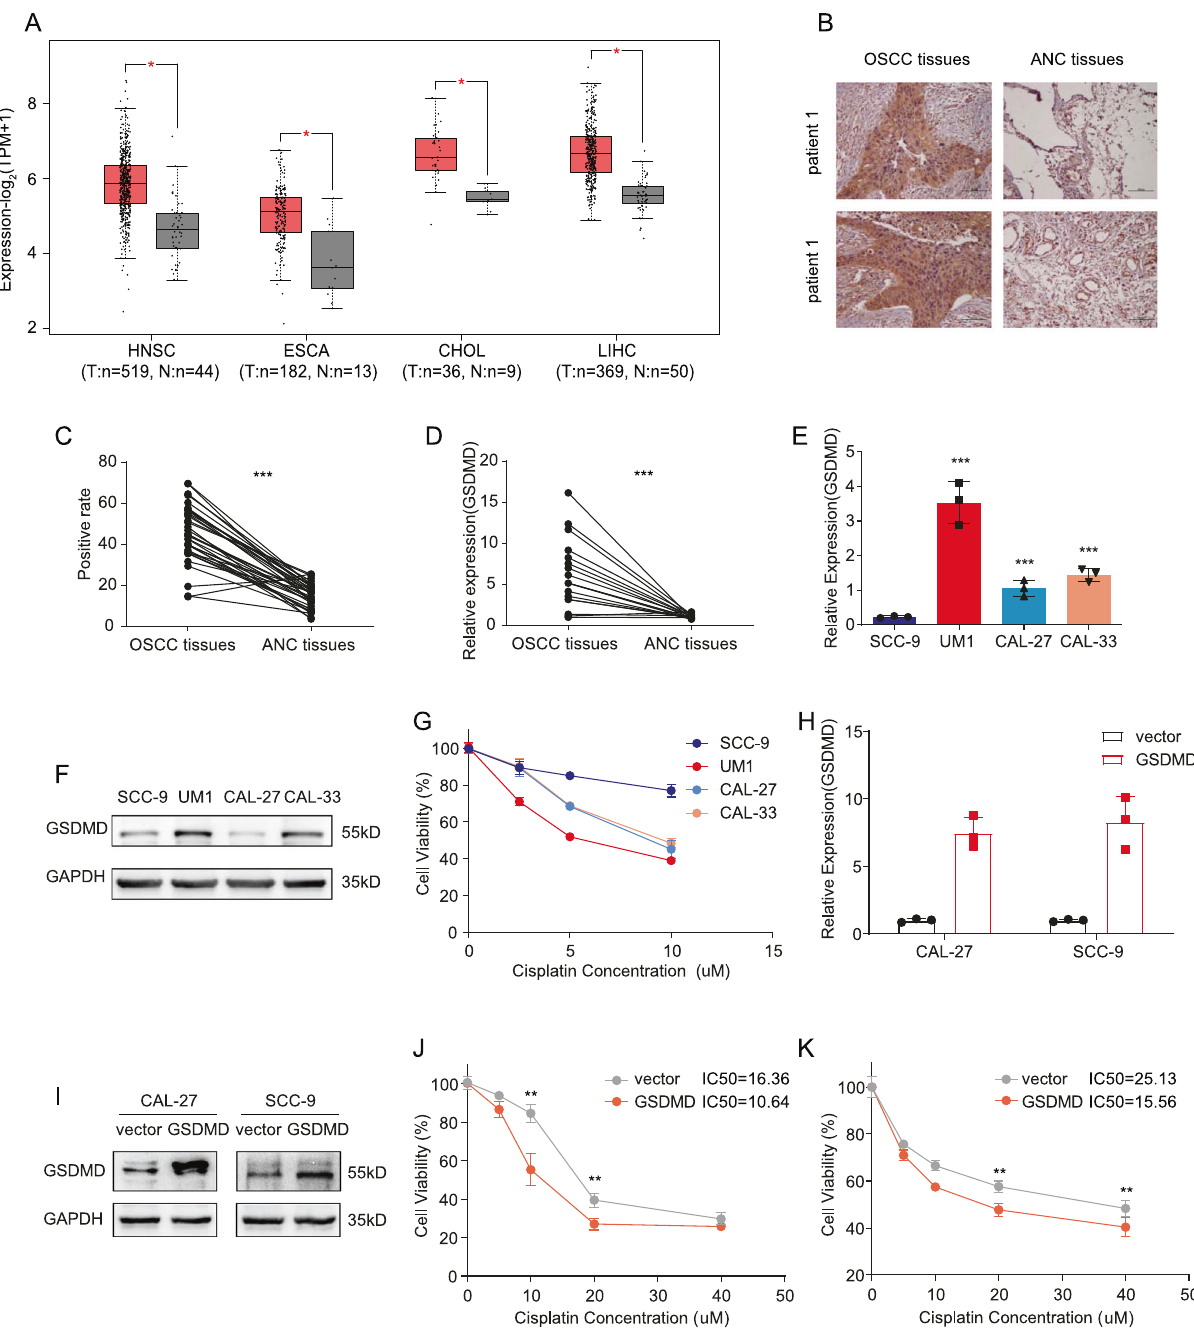
Fig. 1 The expression of GSDMD in cancer tissues and paracarcinoma tissues and its effect on cisplatin sensitivity. A The TCGA database was assessed to determine the expression of GSDMD in cancer and adjacent cancers. B Representative image showed that the expression level of GSDMD in tumour tissues was signi fi cantly higher than that in adjacent tissues (upper and lower show the immunohistochemical staining results of paired tissues from two patients; magni fi cation, 100x). C The statistical results for B ( n = 36). D qPCR showing the expression of GSDMD in tumour tissues and in adjacent normal tissues ( n = 36). E qPCR showing the mRNA levels of GSDMD in multiple cell lines. F Western blot showing the protein levels of GSDMD in multiple cell lines. G Cell lines with different GSDMD expression were treated with cisplatin at a concentration gradient for 48 h to determine the IC50 of cisplatin in each cell line. H , I qPCR ( H ) and western blot ( I ) showing the GSDMD expression in Cal-27 and SCC-9 GSDMD-overexpression stable cell line. J , K A gradient of cisplatin concentrations was used to determine the IC50, the IC50 of control- and GSDMD-overexpressing Cal-27 cells were 16.36 μ M and 10.64 μ M, respectively ( J ). The IC50 of control and GSDMD-overexpressing SCC-9 cells were 25.13 μ M and 15.56 μ M, respectively ( K ). other groups (Fig. 2G). These data indicated that the upstream blotting. The results showed that the cleaved caspase-1 level was effector of GSDMD and the cleavage machine might not function not signi fi cantly different between the cisplatin-treatment group due to low expression; thus, caspase-1 cannot be activated to and the -untreated group. However, the cleaved caspase-3 level cleave GSDMD to release the N-terminus and induce pyroptosis. was increased in the cisplatin-treatment group compared with the